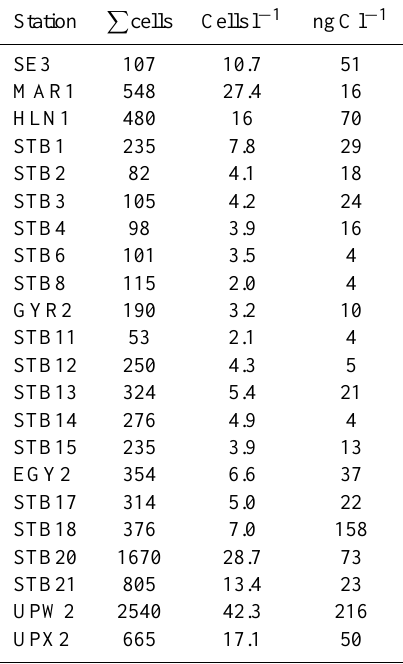
Table 2. Tintinnid summary data. Data were pooled for each sta- tion. Thus, total number of tintinnids examined denoted by P cells, average concentrations of cells and carbon equivalents were cal- culated by dividing station sums by original sample volumes (see Table